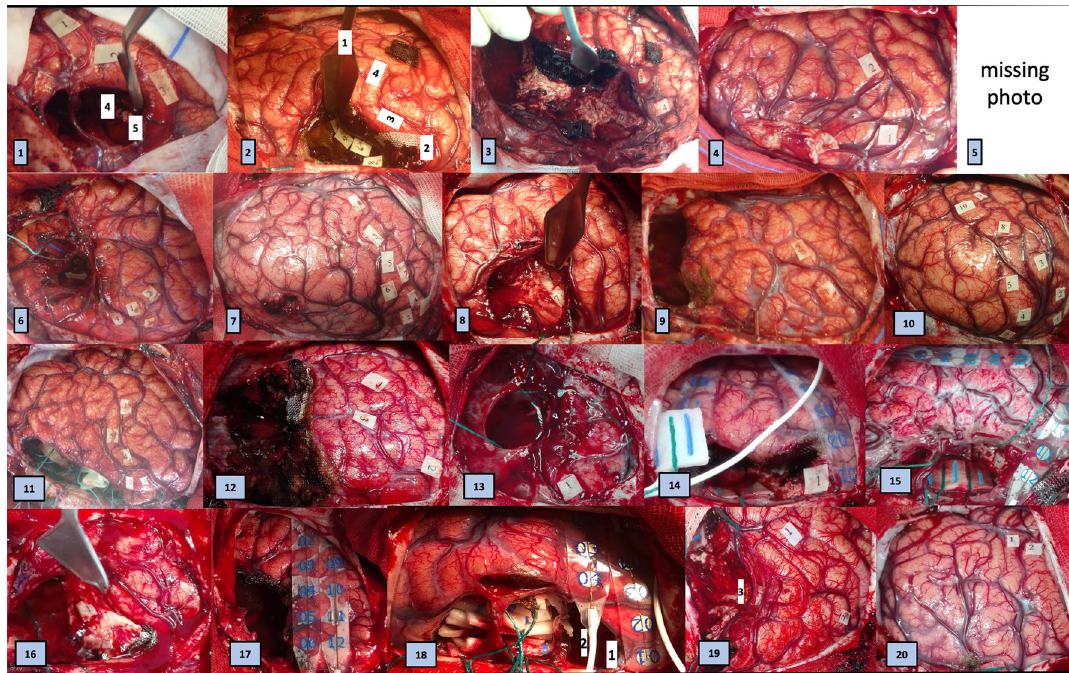
Figure 2. Photographies of intraoperative functional mappings for the 20 cases. No photography was found for case 5.